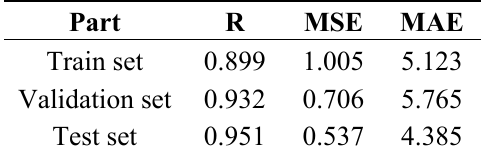
Figure 2. Correlation of neural network (NN) and experimental results for ( a ) validation and ( b ) test sets. Table 3. Statistical parameters of train, validation and test